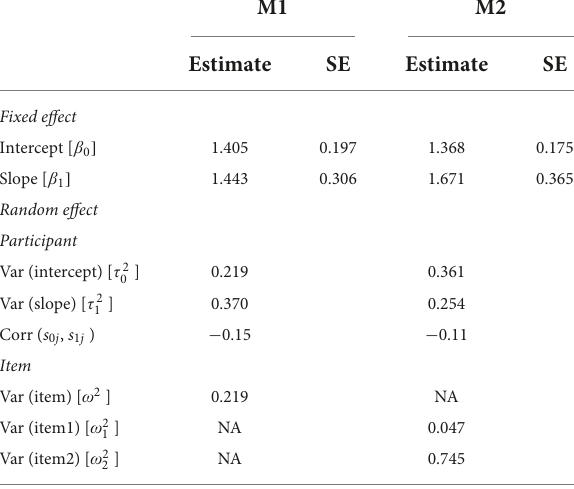
TABLE 4 Estimates of the fixed and random effects of the